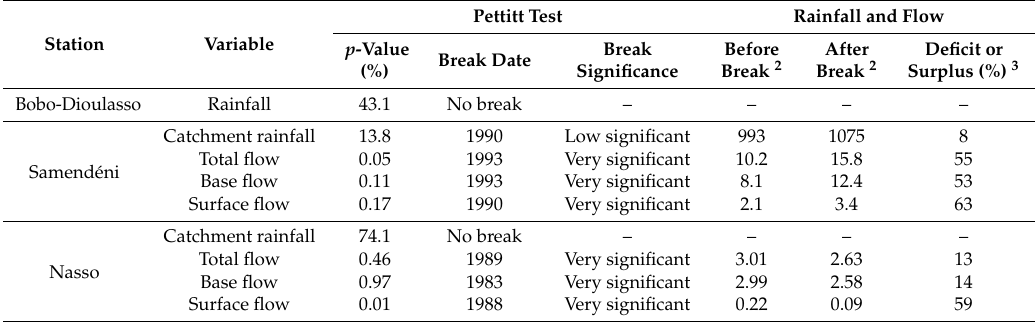
Table 5. Results of break test on the Bobo-Dioulasso rainfall station and the Samendéni gauging station from 1971 to 2014, and on the Nasso gauging station 1 from 1971 to